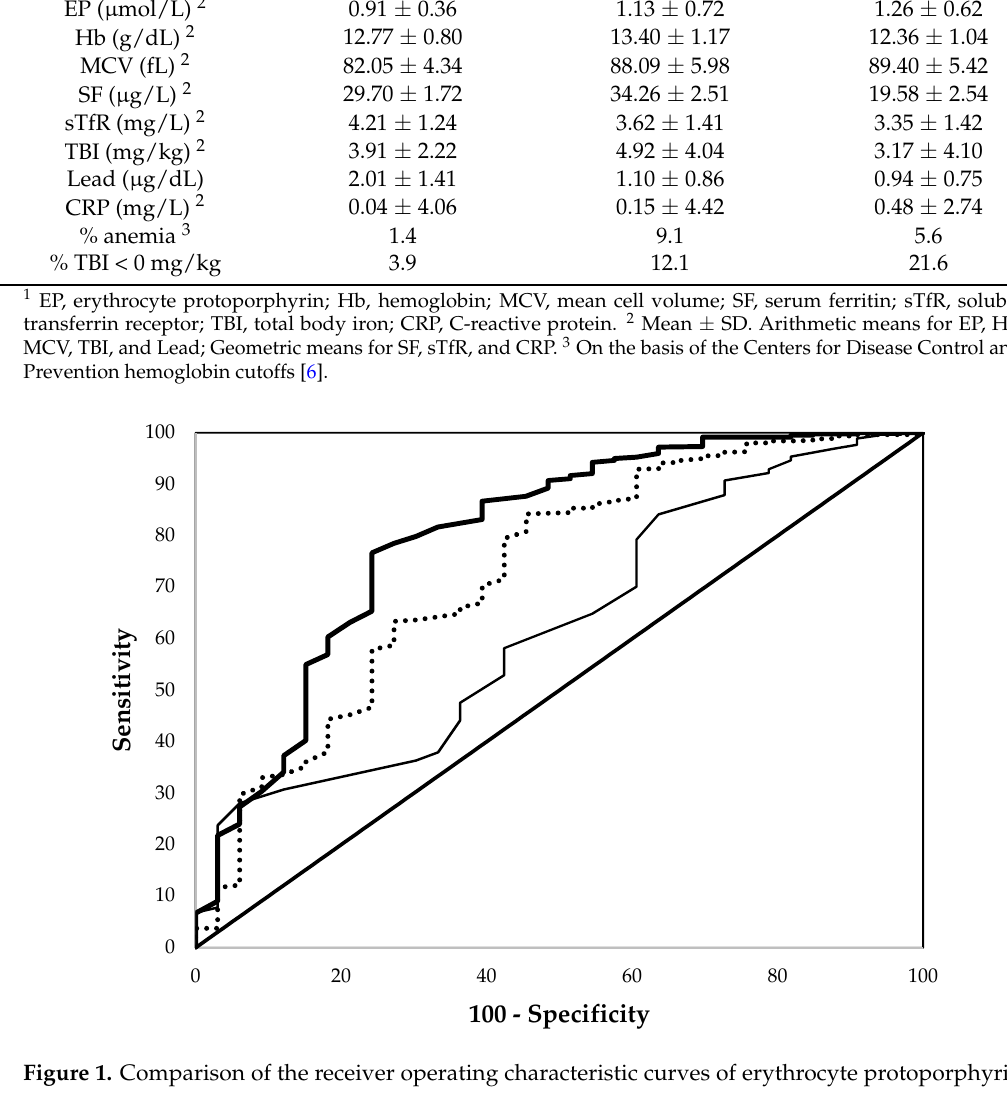
Figure 2. Comparison of the receiver operating characteristic curves of erythrocyte protoporphyrin (thick line), hemoglobin (thin line), and mean cell volume (dashed line) in detecting iron deficiency for non–pregnant women aged 15–49 years from the National Health and Nutrition Examination Surveys 2003–2006.